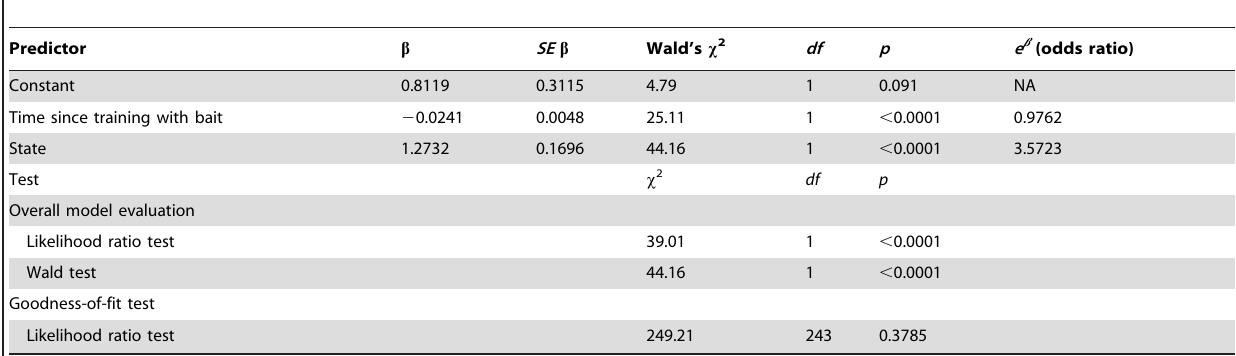
Table 2. Logistic regression analysis of the probability of wolf depredation on hunting dogs in relation to time since training with bait in Wisconsin and Michigan,